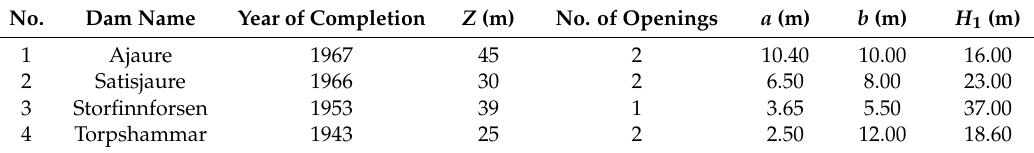
Table 3. Bottom outlets